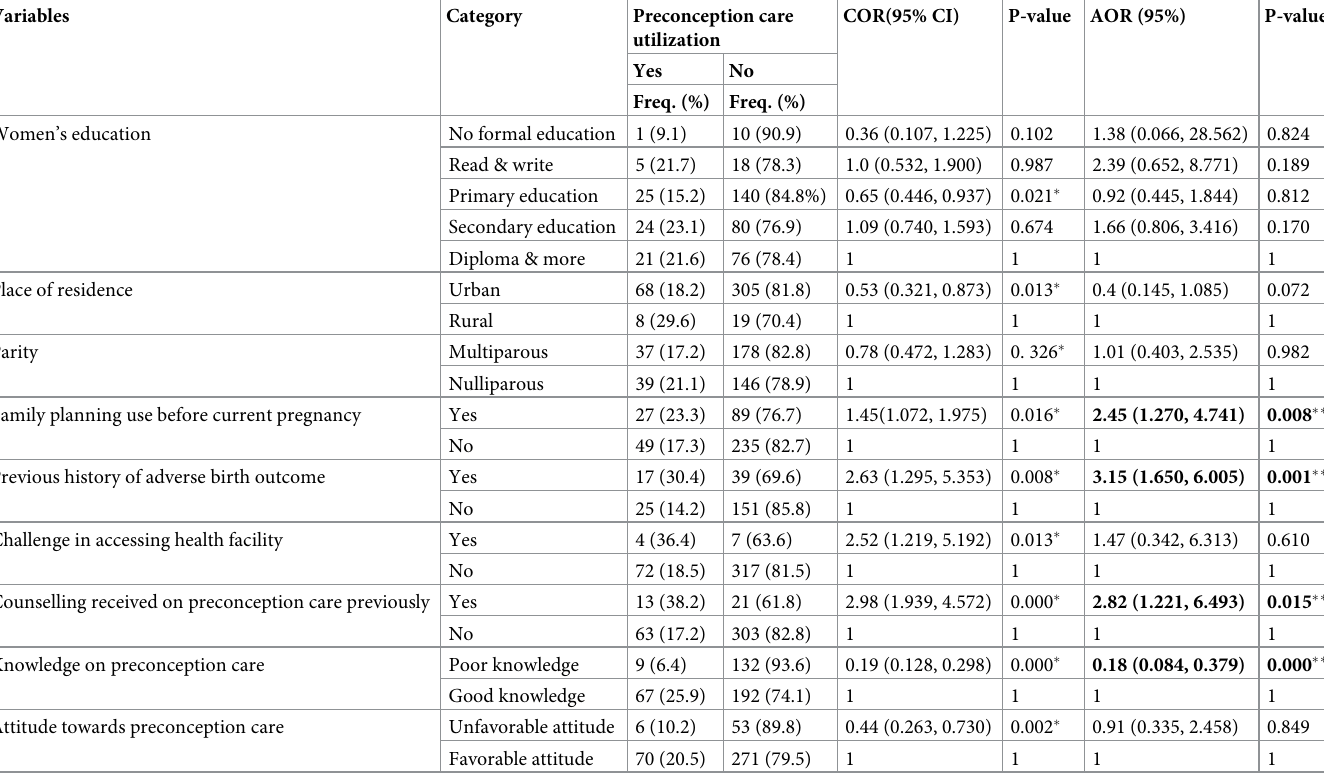
Table 4. Bivariable and multivariable logistic regression analyses for factors associated with preconception care among women attending antenatal care clinics of public health facilities in Hossana town, Southern Ethiopia, 2020.